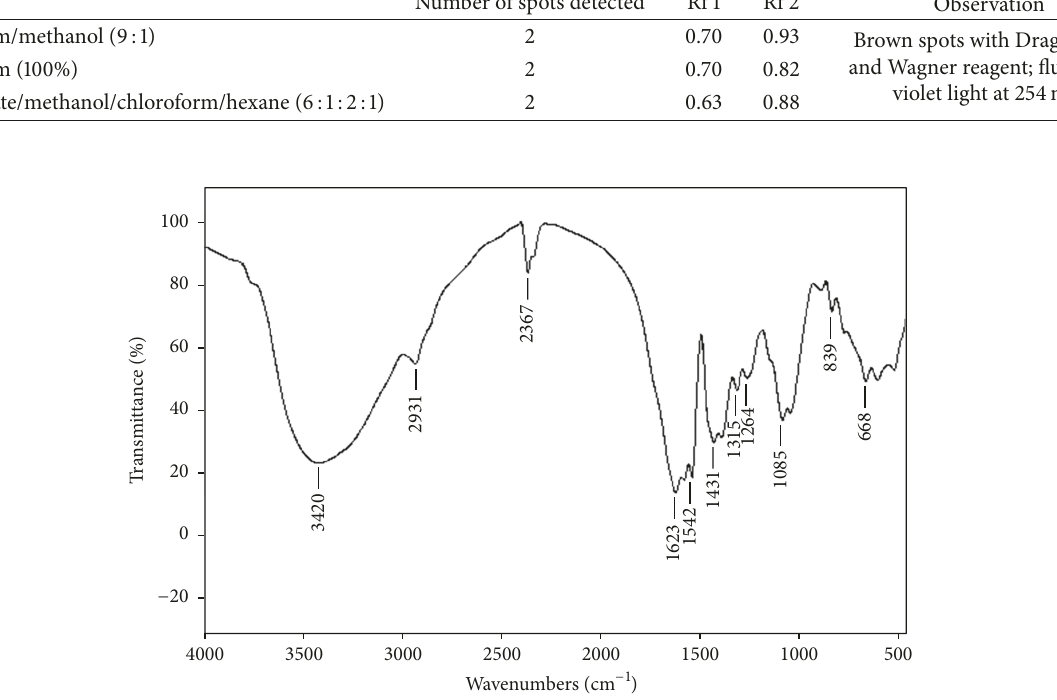
Figure 3: FT-IR spectrum of O. cochenillifera